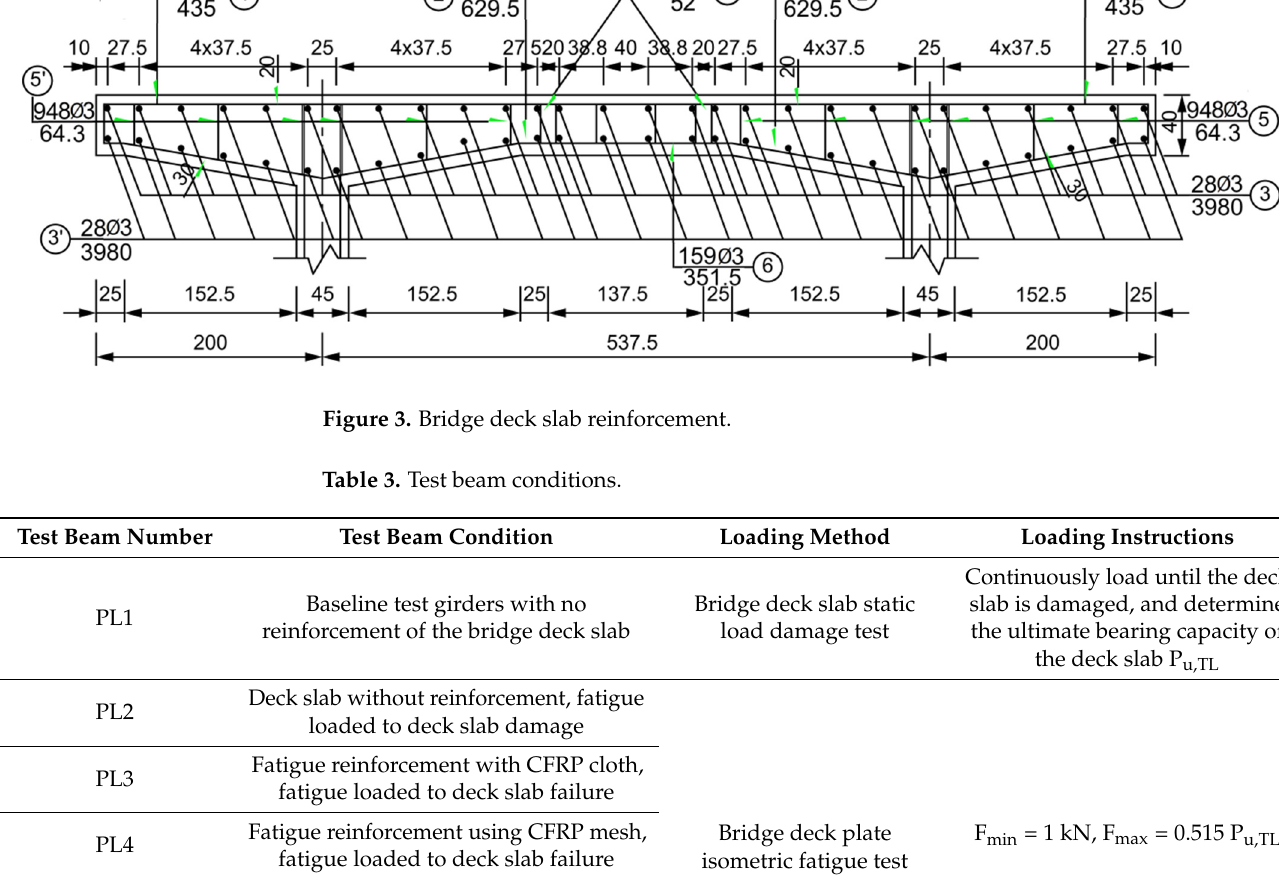
Table 3. Test beam conditions.